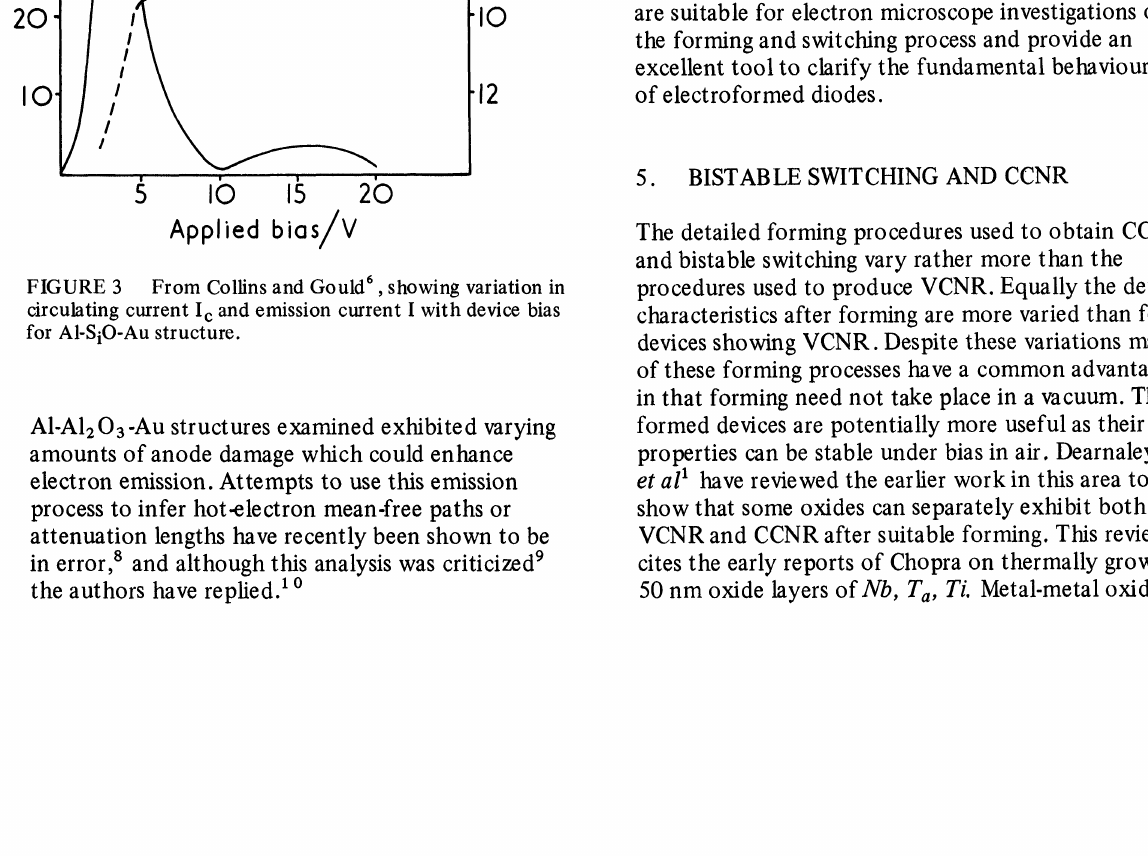
From Collins and Gould showing variation in circuhting current c and emission current with device bias for A1-SiO-Au